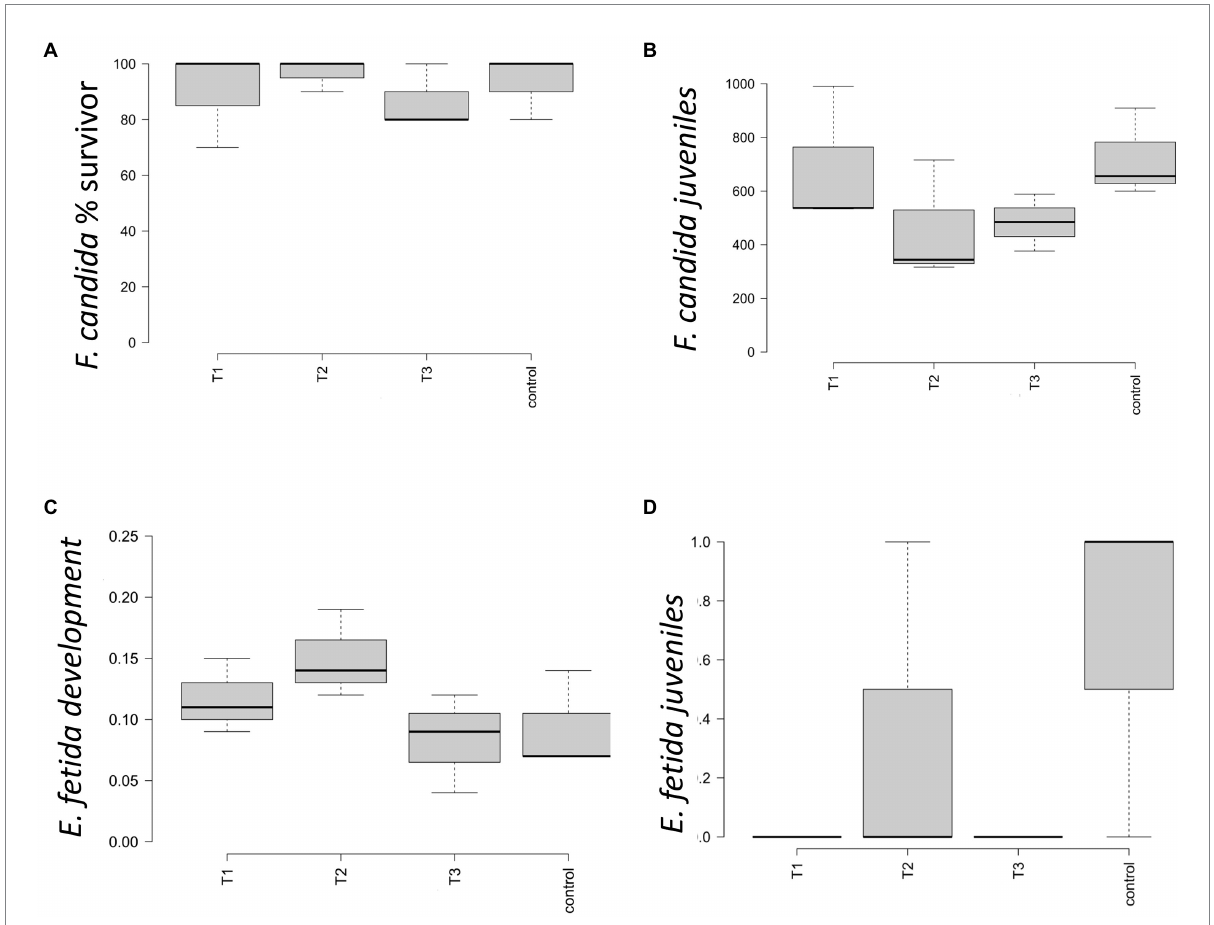
FIGURE 1 Ecotoxicity parameters measured for control = 0 g L − 1 , T1 = 2 g L − 1 , T2 = 4 g L − 1 , and T3 = 40 g L − 1 . The boxplot shows the average and standard error for (A) percentage of surviving springtail F. candida ; (B) number of juveniles springtails F. candida born after 28 days; (C) average and standard error of the Eisenia fetida earthworms’ mass change (%); (D) number of E. fetida juveniles born after 28 and 56 days of test.